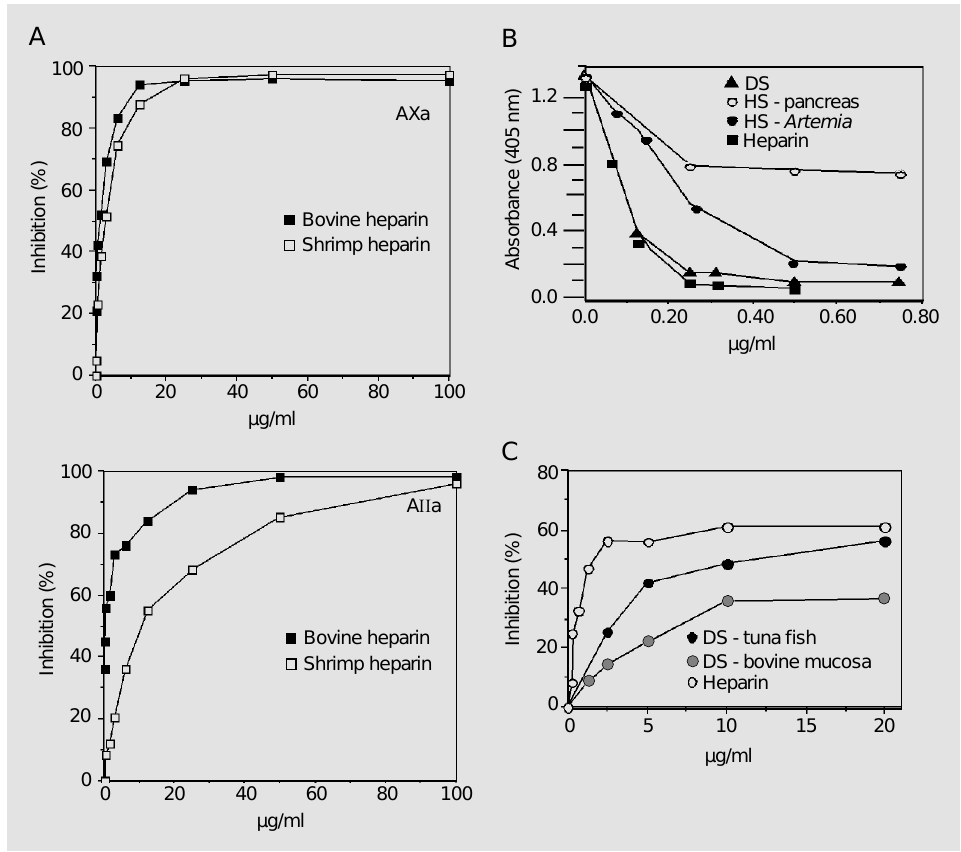
Figure 7. In vitro anticoagulant activities of different heparinoids. A , AXa and A II a activity of shrimp heparin compared to bovine heparin from Ref. 15. B , Heparin cofactor II activity of Artemia franciscana from Ref. 18. C , Heparin cofactor II activity of dermatan sulfate from tuna fish. DS, dermatan sulfate; HS, heparan sulfate. Table 2. Effect of low molecular weight (LWM) and shrimp heparins on the induction of thrombosis by laser shots. Agent Dosage (mg/kg) Injection